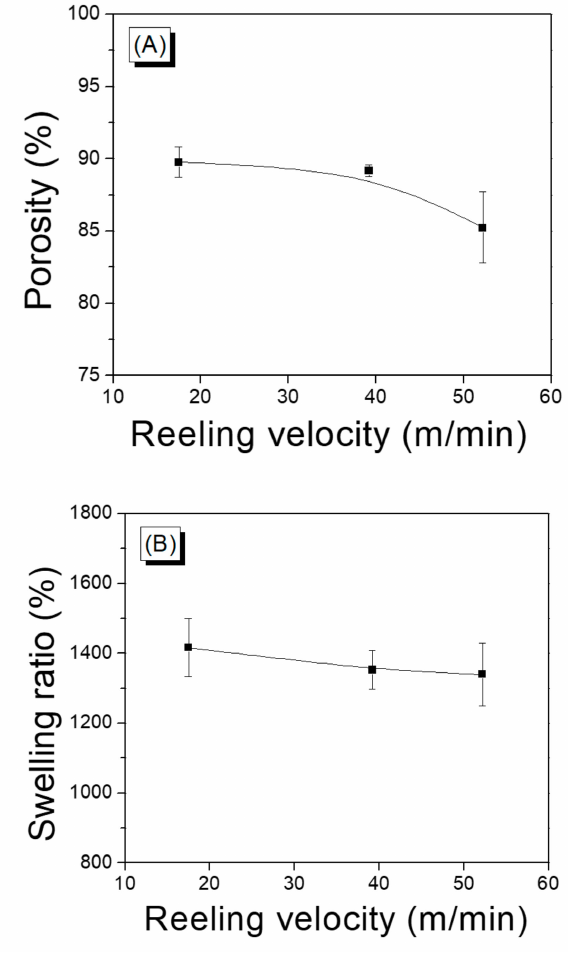
Figure 4. ( A ) Porosity and ( B ) swelling ratio of silk web prepared at various reeling velocities. Reeling bath temperature was 50 ◦ C.